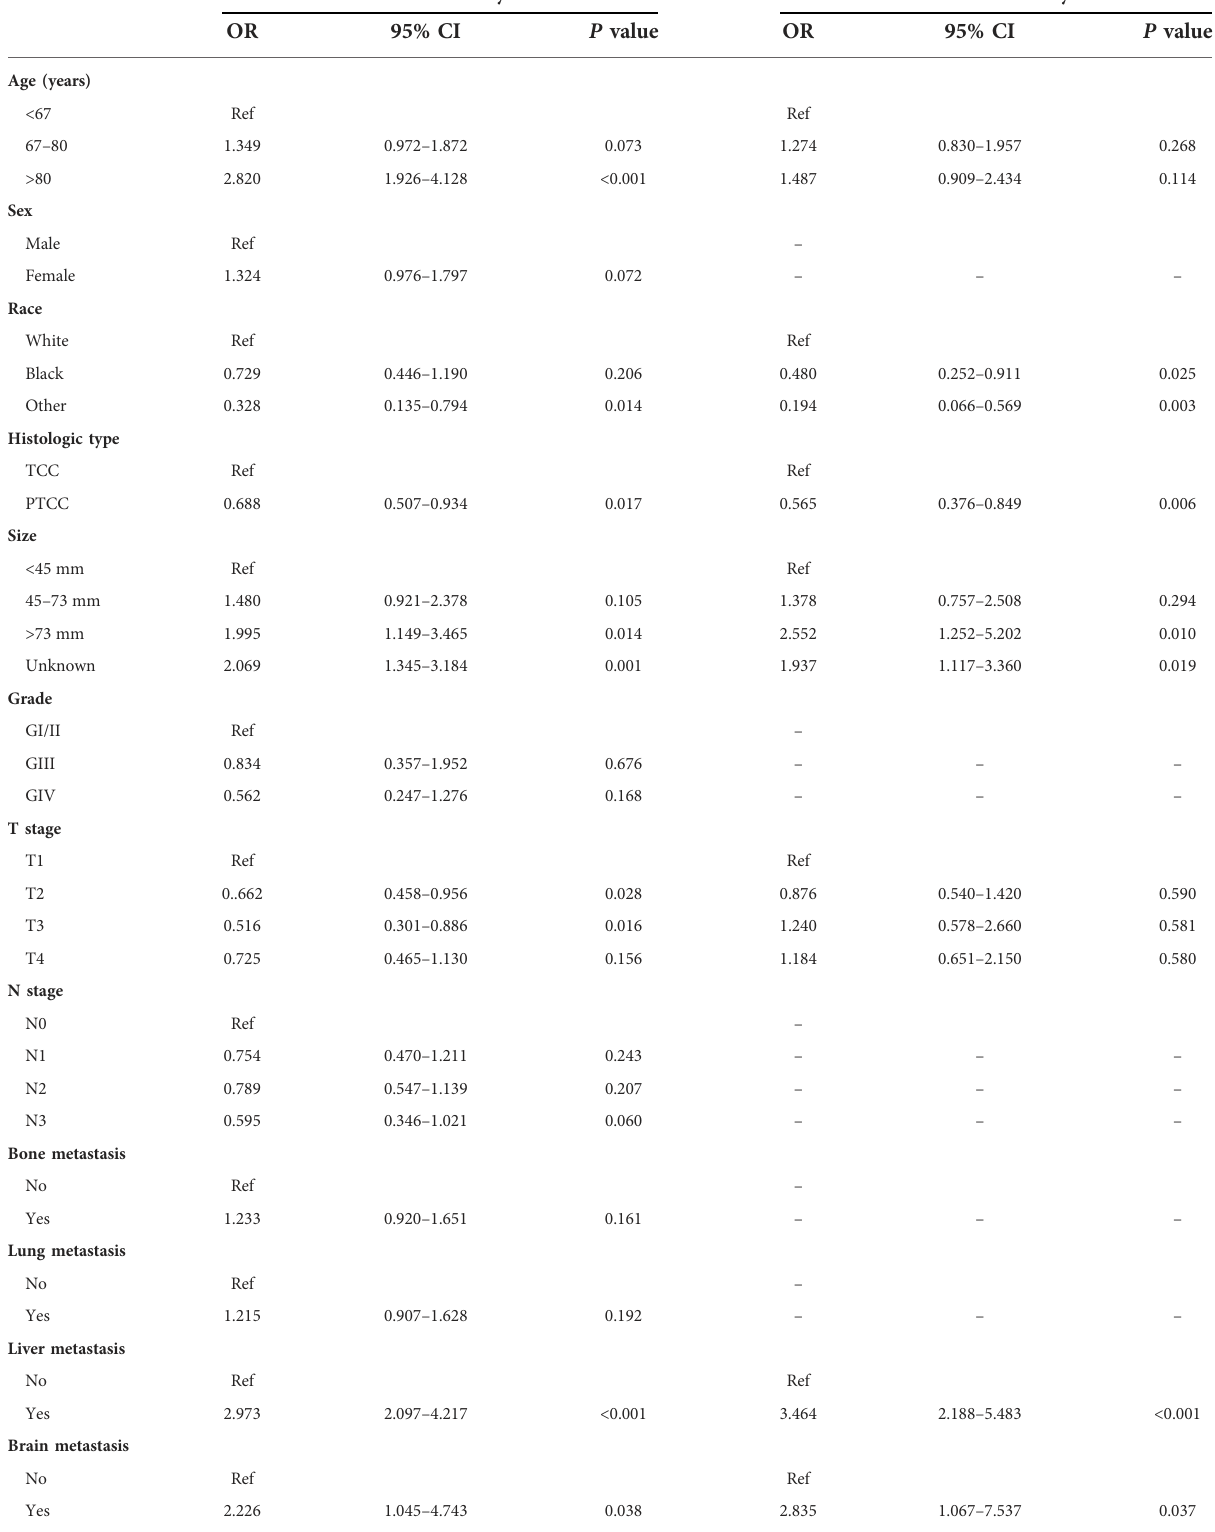
TABLE 3 The univariable and multivariate logistic regression analysis of cancer-speci fi c early death in the training